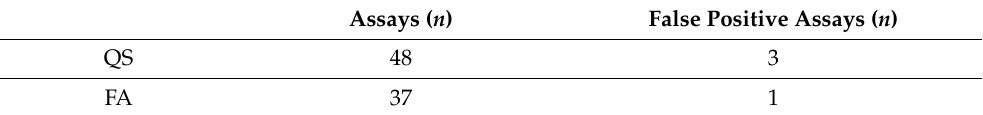
Table 4. QS and FA false positive results.